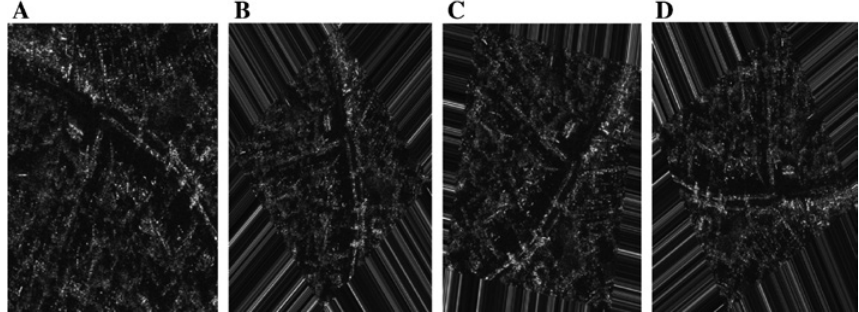
Figure 1: Synthetic Views Generated for Tilt = 2, t Angle Δ φ = 72/ t = 50 ° , θ < 180. Number of views generated is four, i.e. a = 0 ° , b = 51.4 ° , c = 102.84 ° , and d = 154.2 °